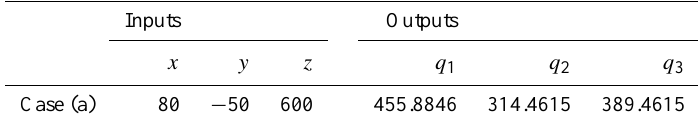
Table 1. Inverse position analysis of the mechanism (unit: mm).